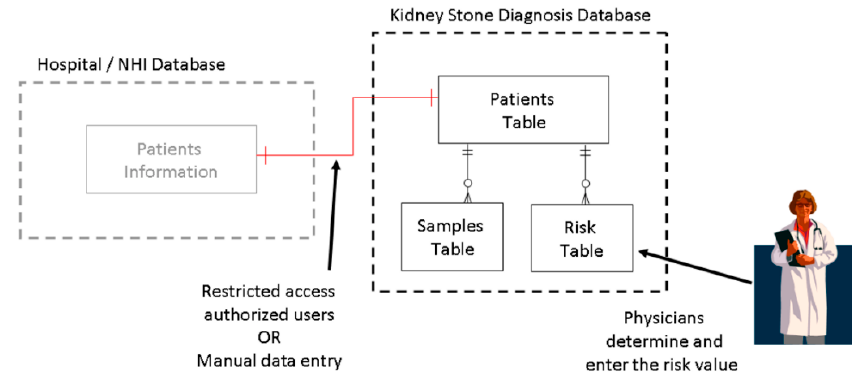
Figure 14. Local database table arrangement.